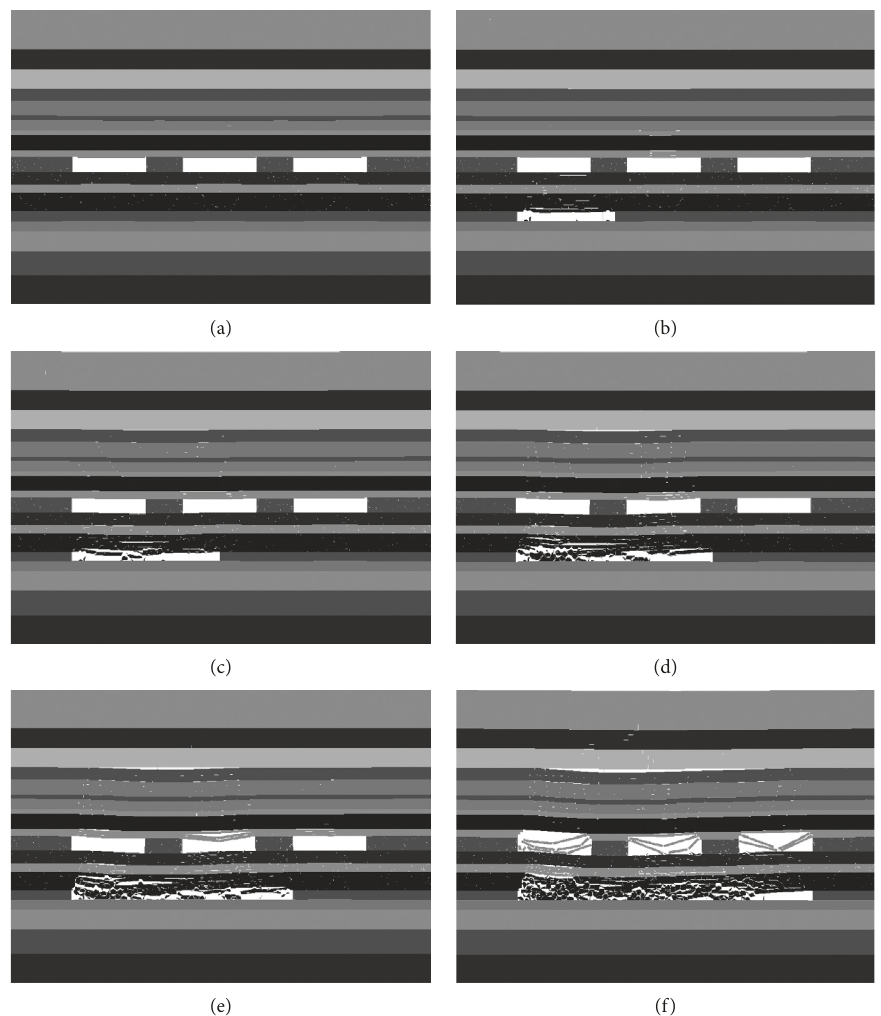
Figure 12: Progressive caving of overlying strata during the advance of panel in the #6 seam. (a) 0m. (b) 40m. (c) 60m. (d) 80 m. (e) 100m. (f)